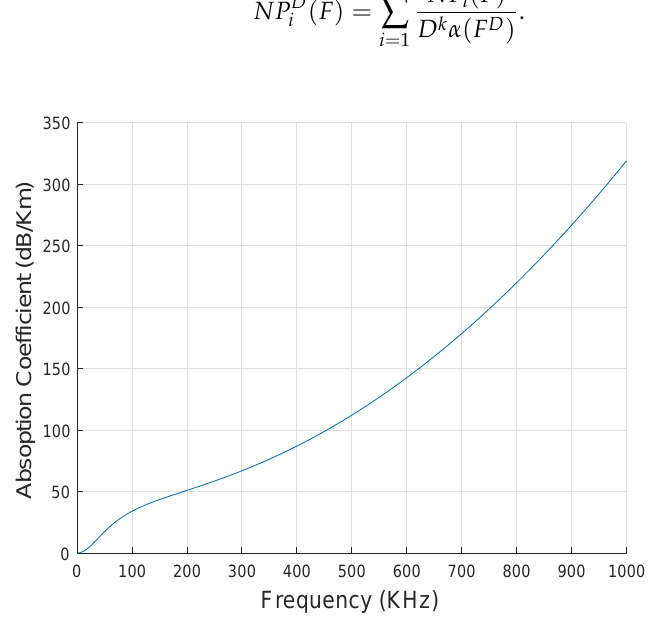
Figure 6. Absorption and Frequency